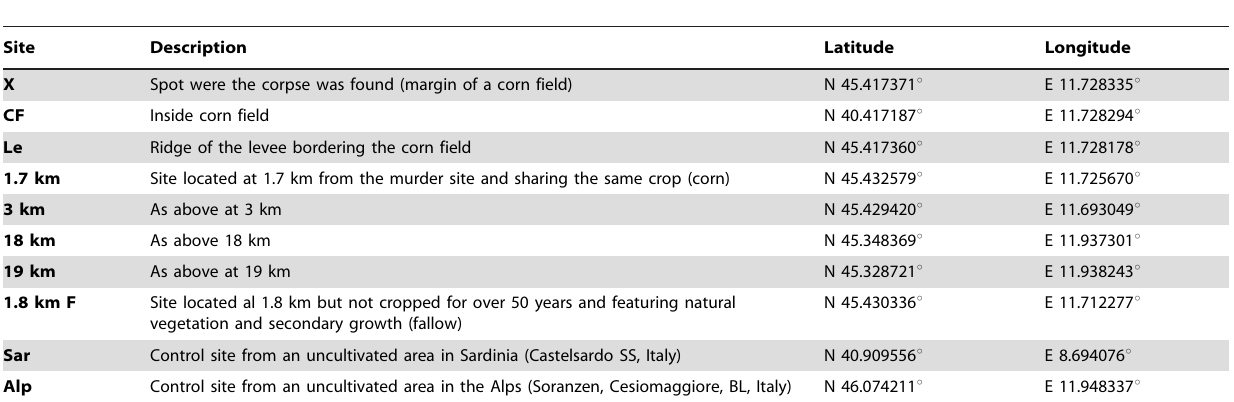
Table 1. Location of sampling sites: latitude and longitude coordinates in decimal values.